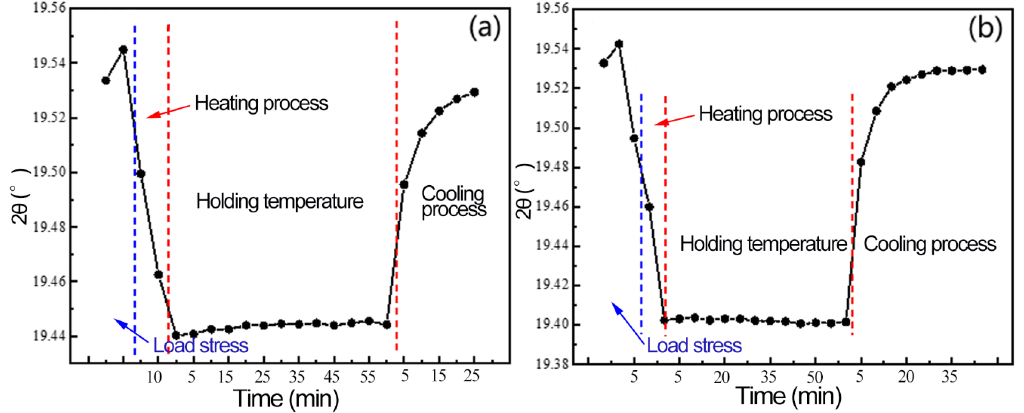
Figure 10. Diffraction angle changes under multiple fields: ( a ) 200 °C, ( b ) 280 °C.